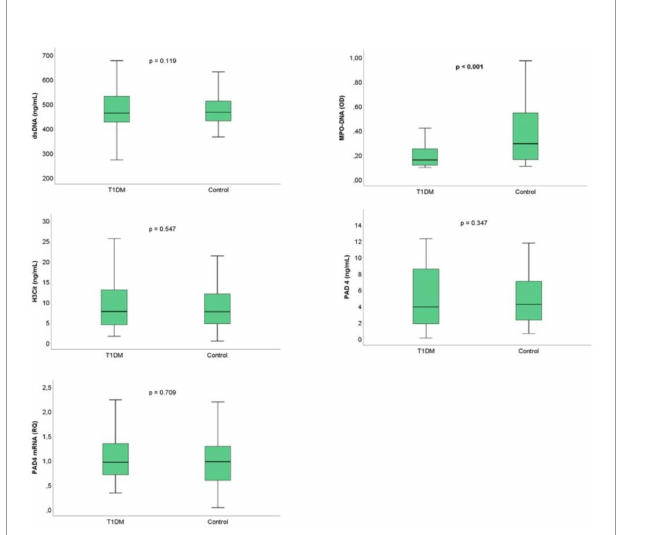
for the control group were 29 (39%), 21 (28%) and, 9 (12%), respectively. We did not fi nd any signi fi cant differences between CCS subgroups and any NETs marker, neither in the total cohort nor in the groups separately ( Figure 4 ). Correlation between CCS and the markers of NETs are included in supplementary materials ( Supplementary Figure 2 ).